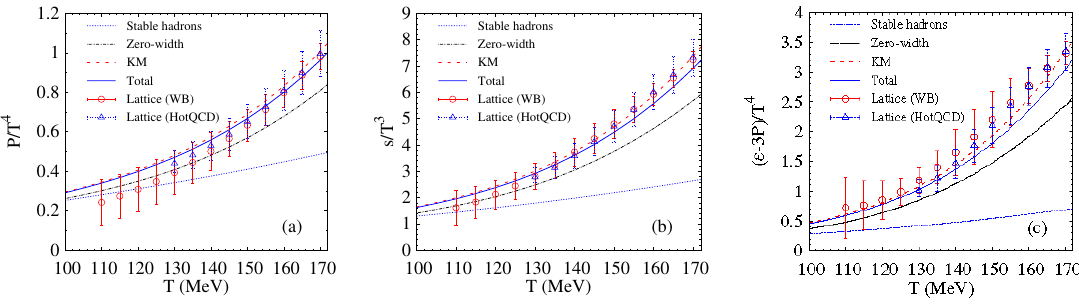
Figure 1. Temperature dependence of ( a ) P / T 4 , ( b ) s / T 3 and ( c ) ( ε − 3 P ) / T 4 at zero chemical potential.